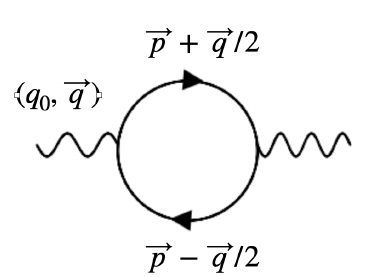
Figure 1 . One loop diagram contributing to G i, 0 µ defined in eq. (3.6). Note, since we are interested in the induced momentum space distribution, we shall only sum over loop frequency (Matsubara frequency), but shall not integrate over the loop momentum p